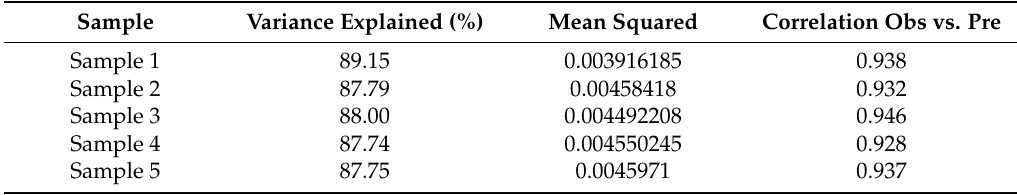
Table 7. Results of the intermediate models created with the Random Forest modelling approach, including the correlation values between observed (obs) and predicted (pre)